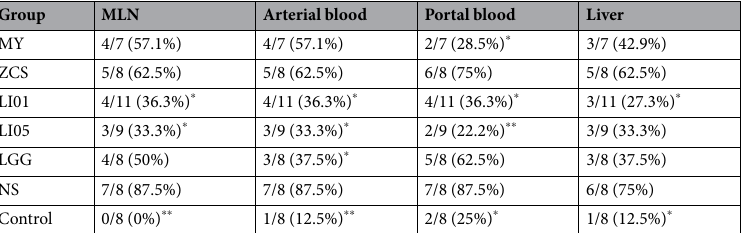
Table 2. Incidence of bacterial translocation in the experimental groups. Results are shown as the number of rats with positive culture in different tissues; percentages are parenthesized. * P < 0.05, ** P < 0.01 compared with the NS group. MLN, mesenteric lymph